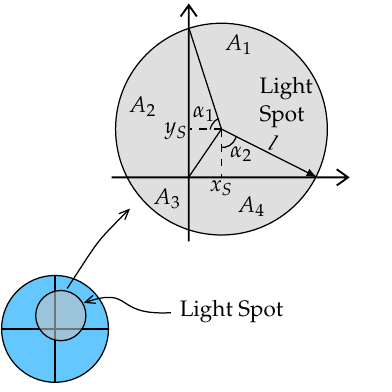
Figure 2. Geometry of the light spot of a light beam, where x S = [ r S , q ] 1 and y S = [ r S , q ] 2